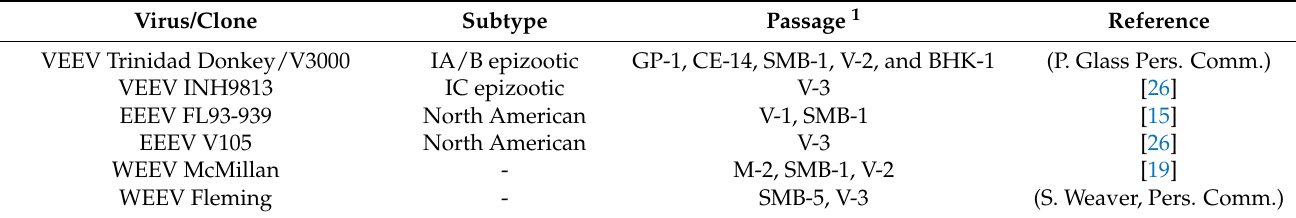
Table 1. In vitro passage history of biological isolates used for cDNA clone